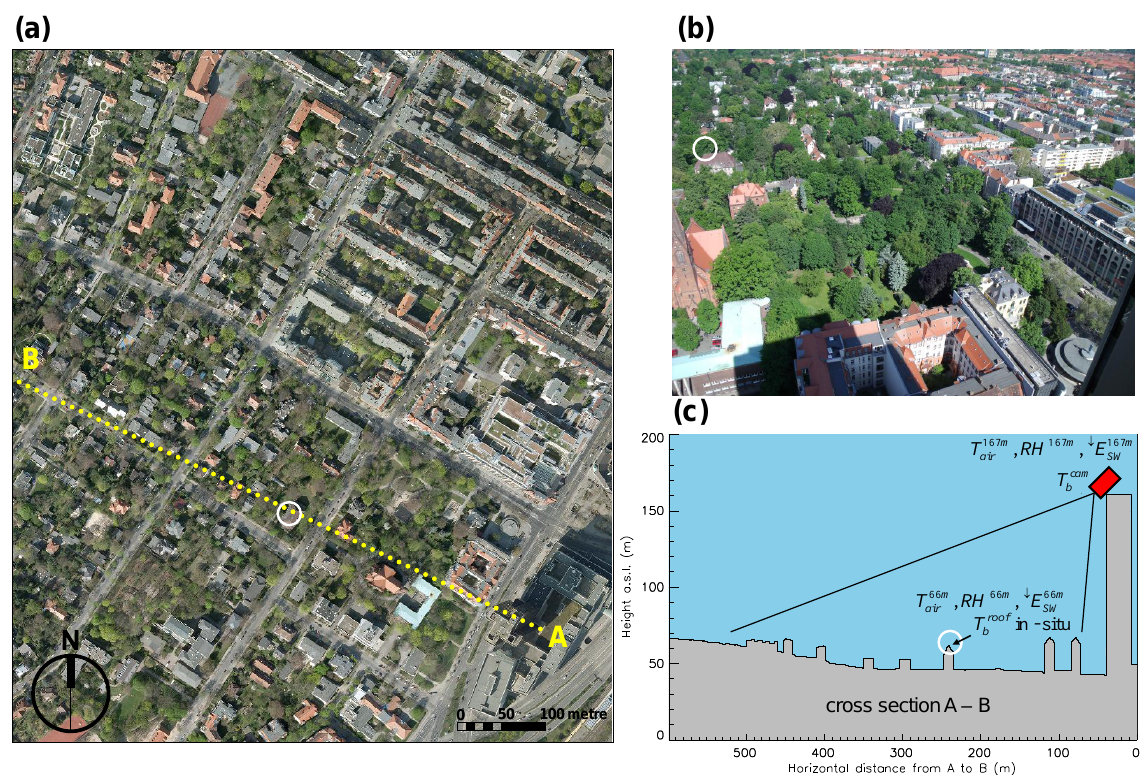
Fig. 2. (a) Aerial photo of the study site and meteorological measurement site (white circle) (aerial photo with permission of Berlin Depart- ment of Urban Development, Urban and Environmental Information System), (b) photograph showing approximately the FOV of the TIR camera, (c) cross Sect. A–B illustrates the experimental setup e.g. surface heights, location of TIR camera and in-situ measurements.